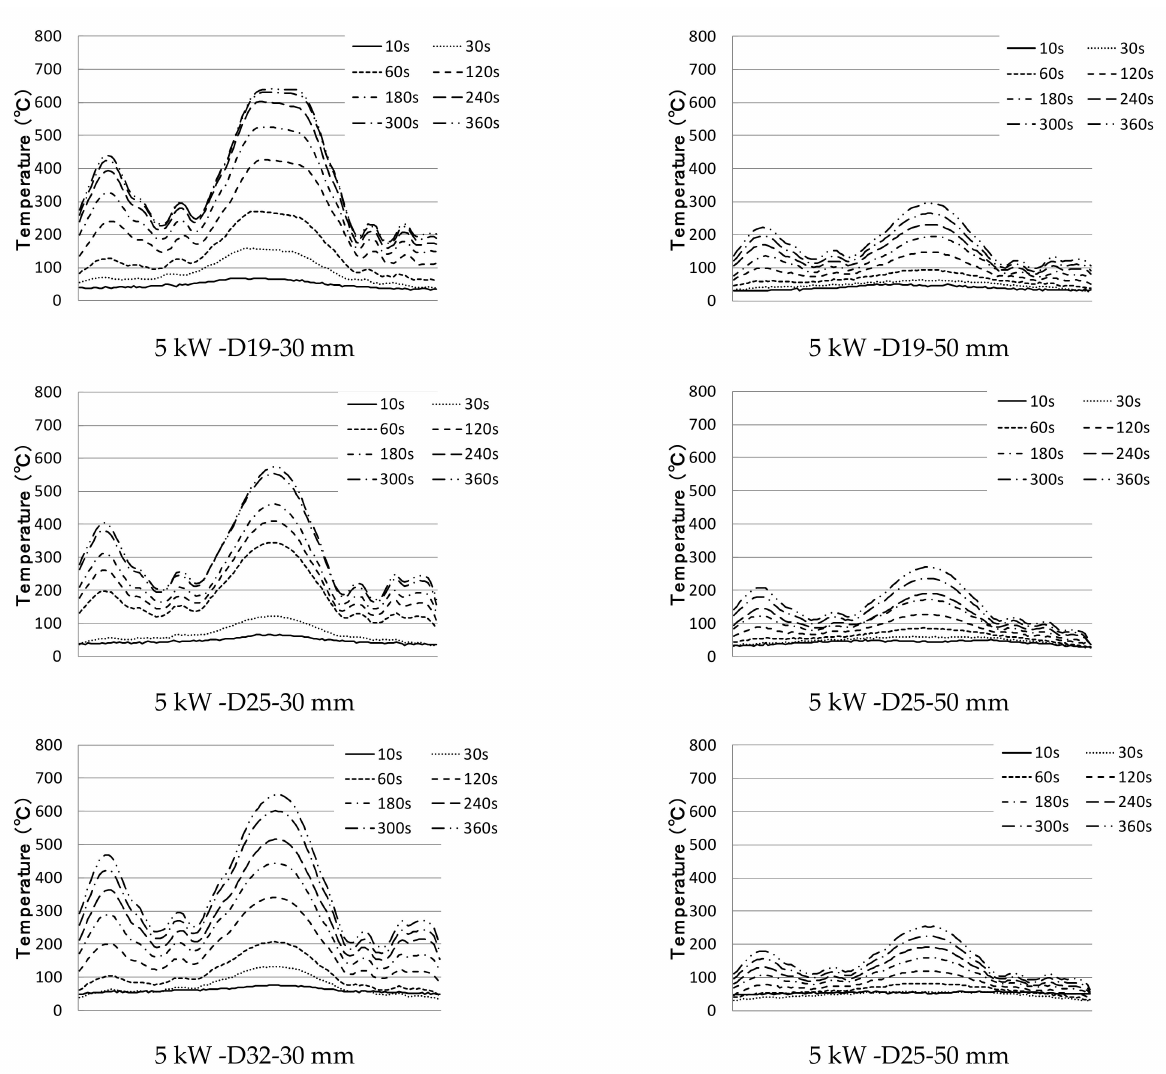
Figure 9. Temperature distribution of reinforcing bar by induction heating (5 KW–150 mm). In the case of a 5 kW output for the 430 mm specimen reinforcement heating experi- ment, the diameter of the heating coil was 120 mm. Therefore, the points were measured at a distance of 30 mm in the reinforcement length direction based on the direct light center of the coil, and the results are shown in Figure 10. The 430 mm specimen at 10 kW output was tested in the same way, and the results are shown in Figure 11. The temperature difference between the inside and outside of the coil diameter was not significant; however, the temperature difference between the outside 30 mm and 100 ◦ C was removed from the magnetic field area from the outside 60